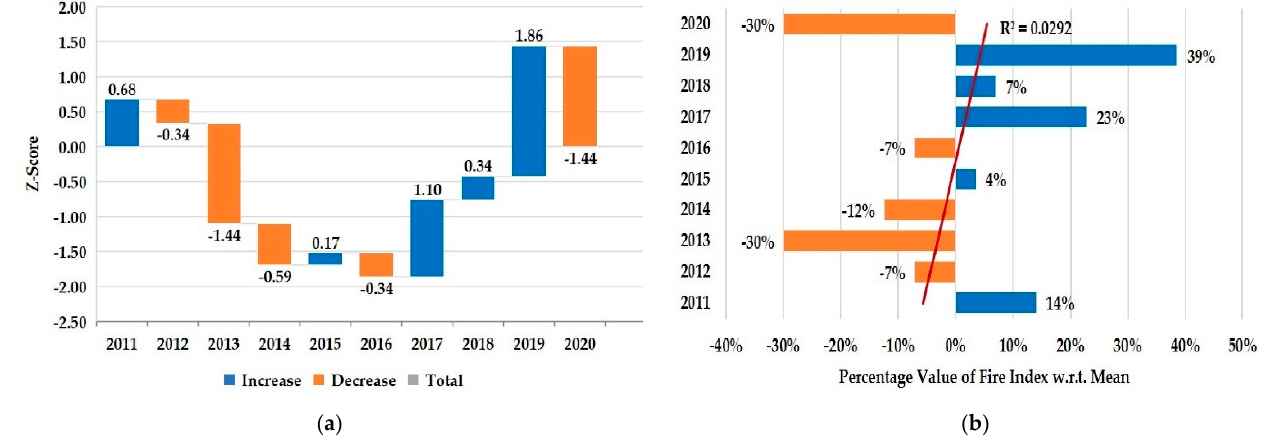
Figure 11. Temporal fire incidence pattern: ( a ) Z-score waterfall chart; ( b ) proportional fire index.